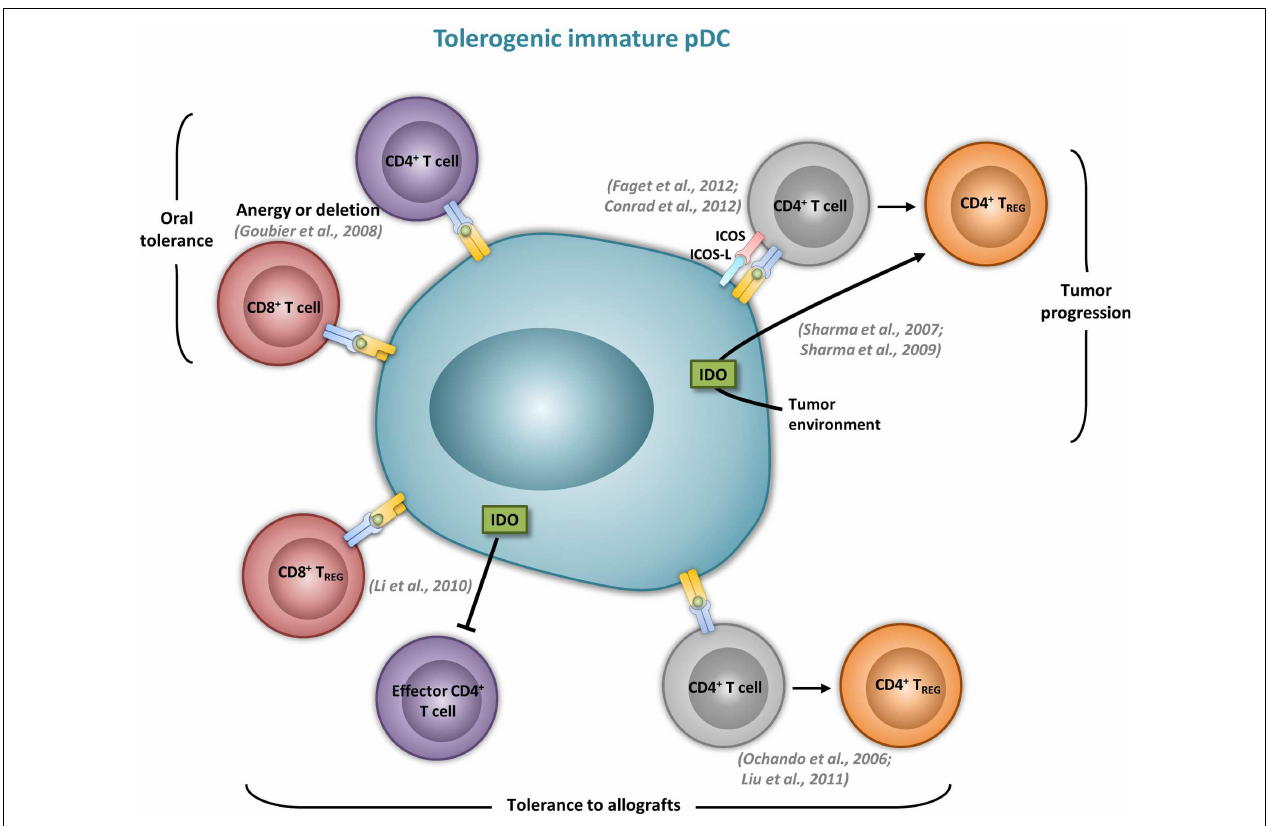
FIGURE 2 | Immature pDCs induce tolergenicT cell responses. The most relevant in vivo experimental animal systems are represented in this